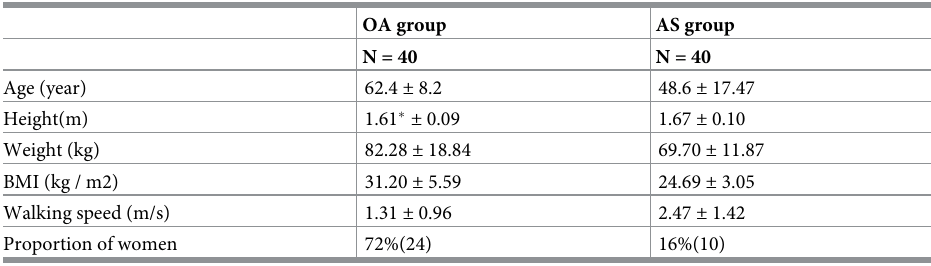
Table 1. General subject